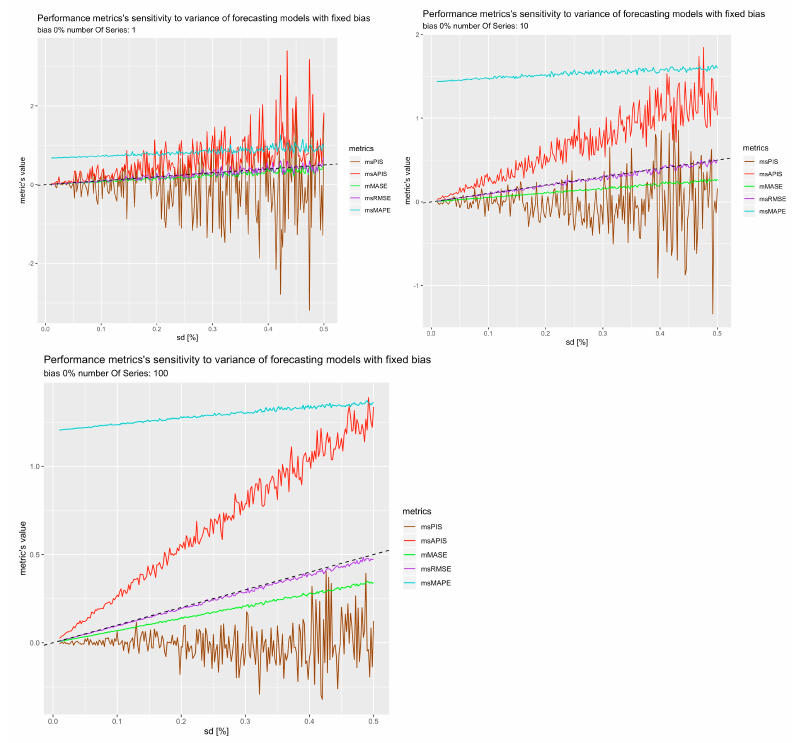
Figure 21. Standard deviation sensitivity when averaging results of 1, 10, and 100